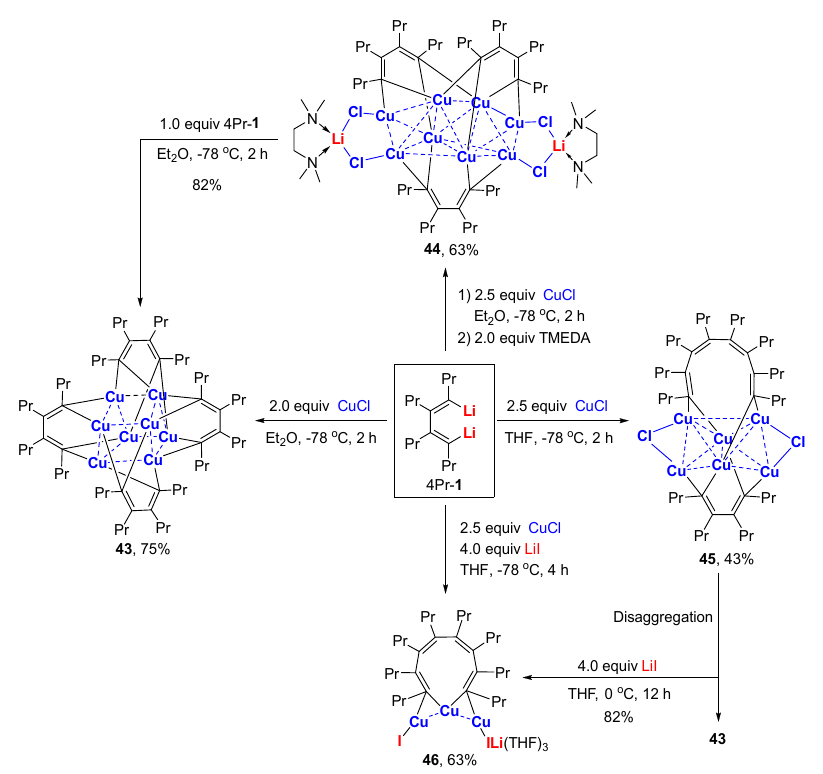
Scheme 12. Conjugate C,C-bidentate organocopper aggregates [56].